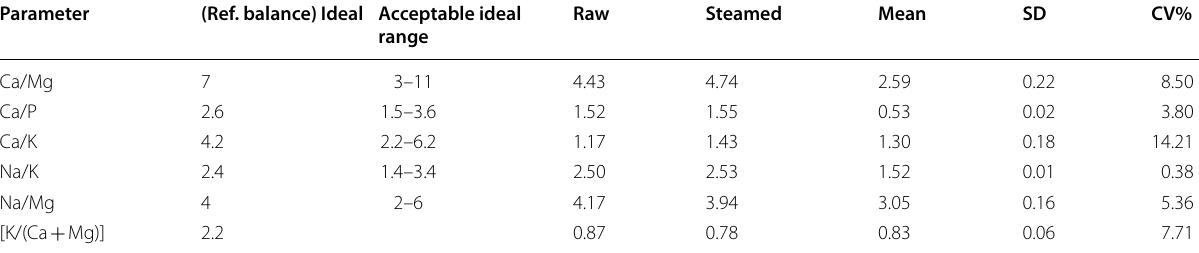
Standard deviation (SD), coefficient of variation per cent (CV %), difference between raw and cooked (D), percentage difference (D) *significant difference Table 3 Mineral ratio in raw and steamed flesh of African Mud Creeper, T. fuscatus var radula